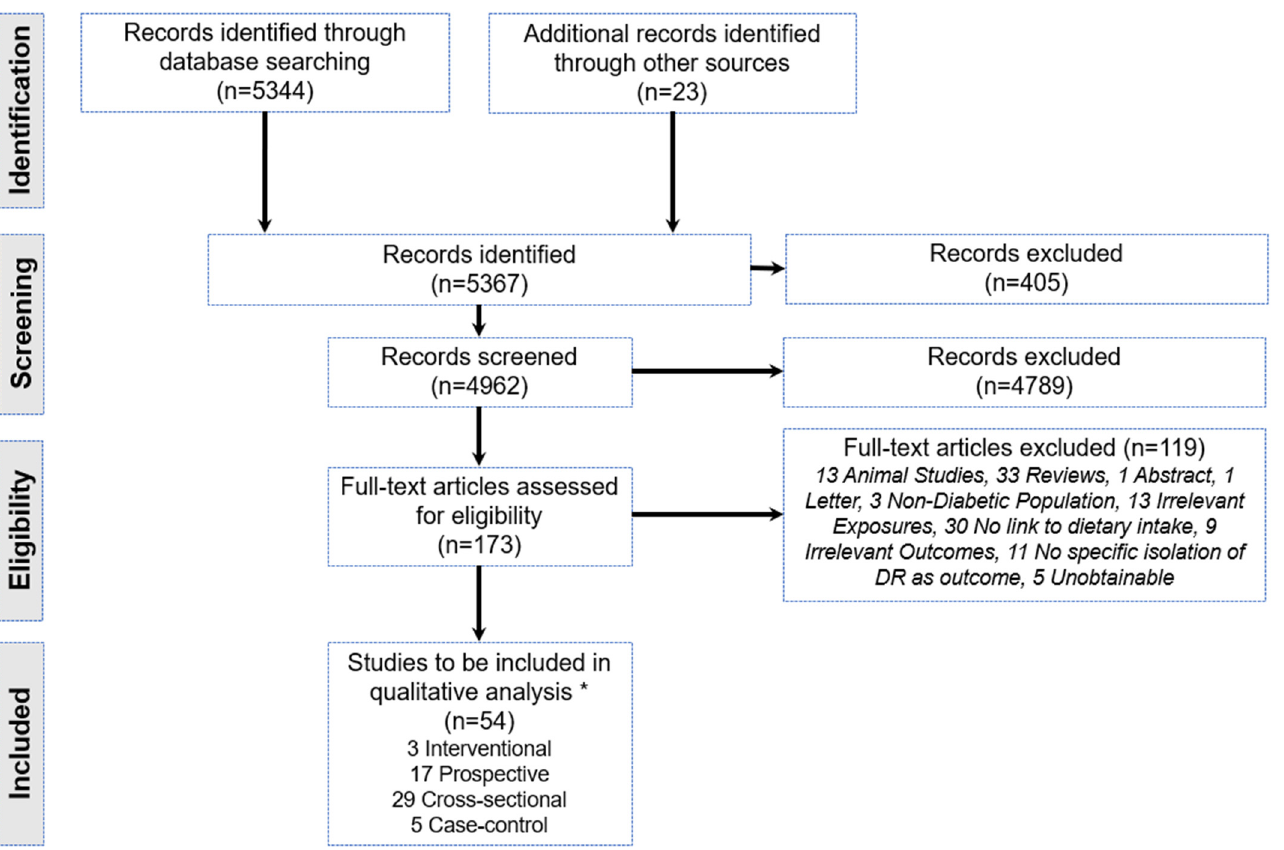
Figure 2. PRISMA flow diagram for the systematic review detailing the database searches, the number of abstracts screened, and the full texts retrieved. * Some studies analyzed >1 dietary component.